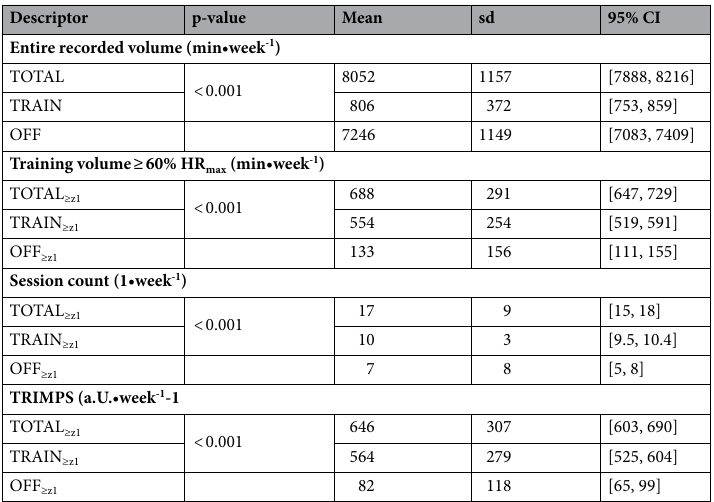
Table 3. Weekly averages of training descriptors in eight rowers during the study period (30–45 weeks). TRAIN training or activity data recorded during scheduled training, OFF recorded outside of TRAIN, TOTAL sum of TRAIN + OFF, the suffix ≥z1 implies only data of intensities ≥ 60% of maximum heart rate (HR max ), TRIMP training Impulse calculated as activity zone (1–3) times duration (minutes) adapted from Banister et al. 20 . p-values are based on paired t tests between TOTAL vs. TRAIN for each variable. Mean values are provided as arithmetic mean, sd standard deviation, CI confidence